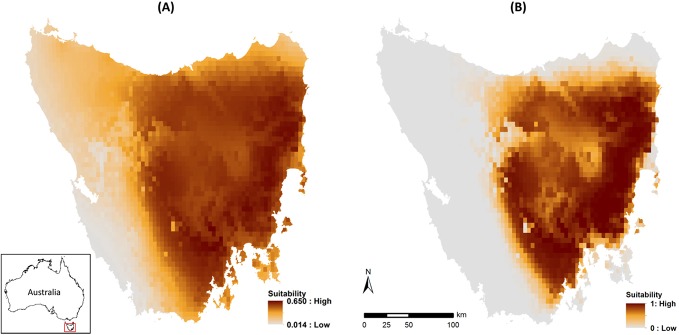
Weather-defined species distribution models for the eastern quoll in Tasmania, showing (A) habitat suitability (logistic output) and (B) core distribution (binary output).Projections are a composite of the 720 individual monthly projections between January 1950 and December 2009 (individual monthly projections shown in S1 Video). The value for each 5 km x 5 km grid cell represents the average suitability for that cell across the 720 individual months. Grey shading indicates not suitable, with increasing suitability shown from orange to red. Inset shows location of Tasmania within Australia.